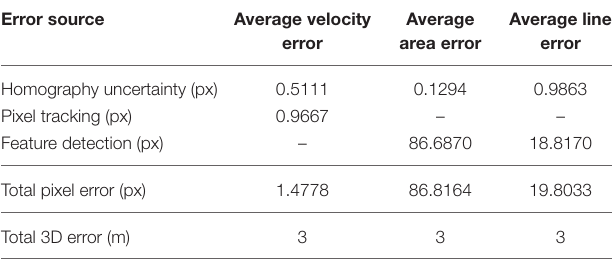
TABLE 1 | Error estimations for deriving velocity, area and line measurements using